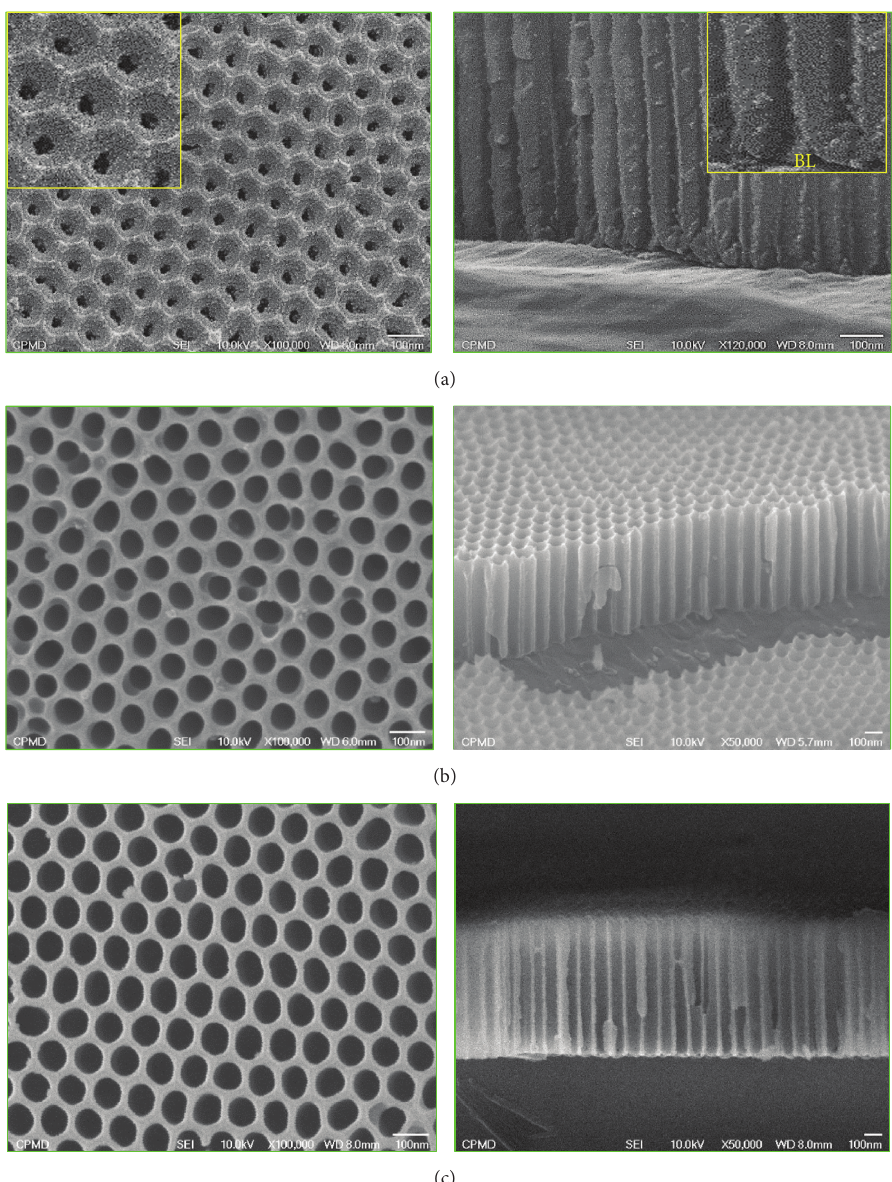
Figure 1: Top view, left column, and cross-sectional view, right column, FE-SEM images of PAA membranes (a) as-prepared after 𝑡 2 nd = 10 min, (b) after posttreatment of 𝑡